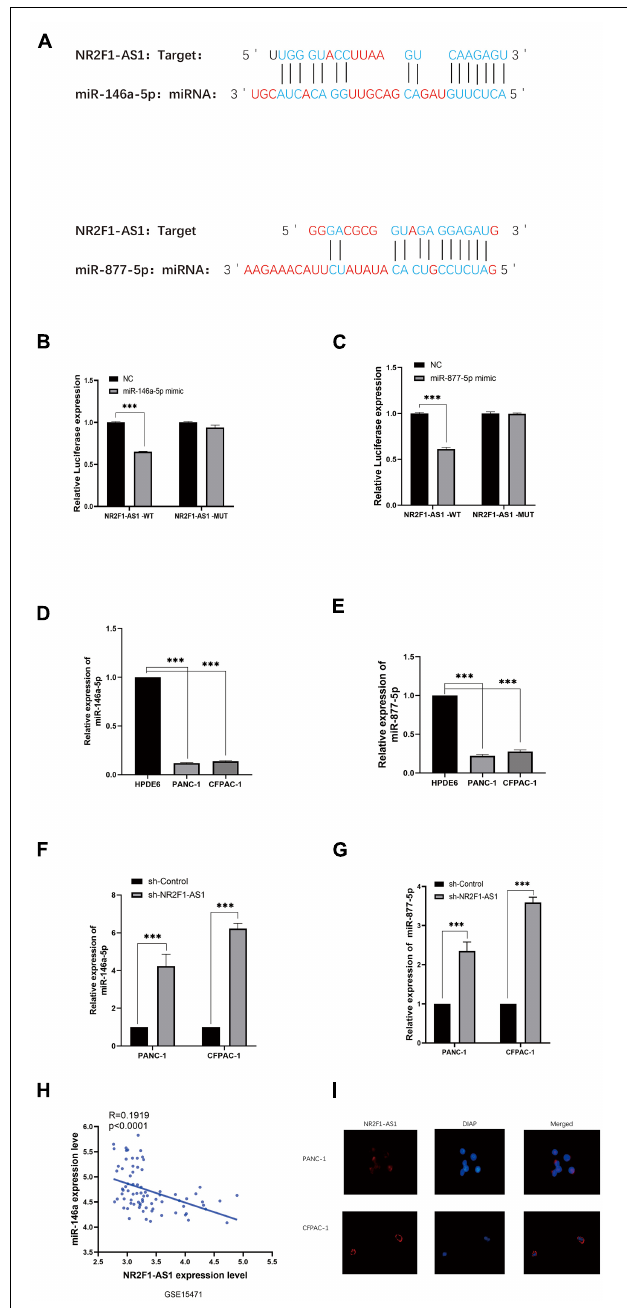
FIGURE 4 | NR2F1-AS1 interacts with miR-146a-5p/miR-877-5p in PDAC. (A) Prediction of target sites for miR-146a-5p/miR-877-5p in NR2F1-AS1 based on the online program. (B,C) Luciferase reporter assay showed that miR-146a-5p/miR-877-5p overexpression significantly suppressed the activity of the reporter containing wild-type NR2F1-AS1. (D,E) Expression levels of miR-146a-5p and miR-877-5p in PANC-1 and CFPAC-1 cells. (F,G) RT-PCR was performed with sh-NR2F1-AS1-transfected PANC-1 and CFPAC-1 cells to determine the effects of NR2F1-AS1 on miR-146a-5p and miR-877-5p. (H) Expression of NR2F1-AS1 was negatively associated with the expression of miR-146a-5p in 39 PDAC tissues from GSE15471. (I) FISH images showing the localization of NR2F1-AS1 in PANC-1 and CFPAC-1 cells. Statistical significance: *** p <